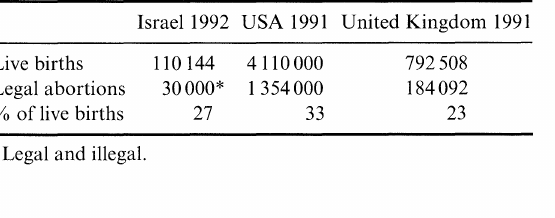
TABLE VI Live births and abortions in Israel, USA